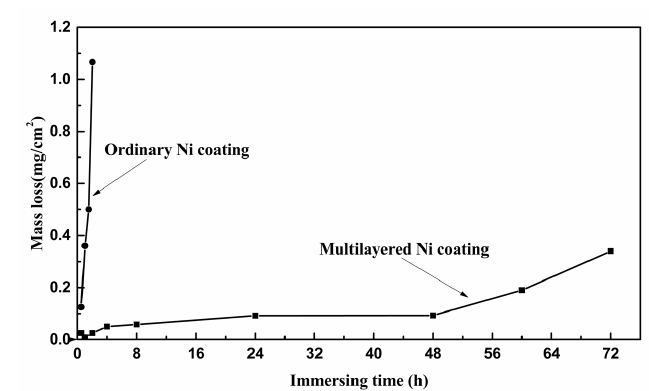
Figure 7. Immersing experiment results of the Ni coating samples in 7 vol.% HCl